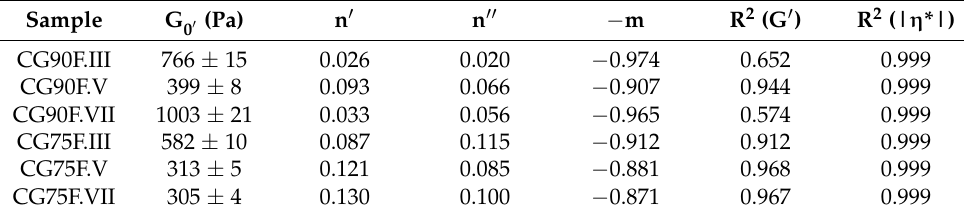
Table 3. The experimental results of n (cid:48) , n (cid:48)(cid:48) , m, A, and R 2 values of XG-based composite hydrogels.